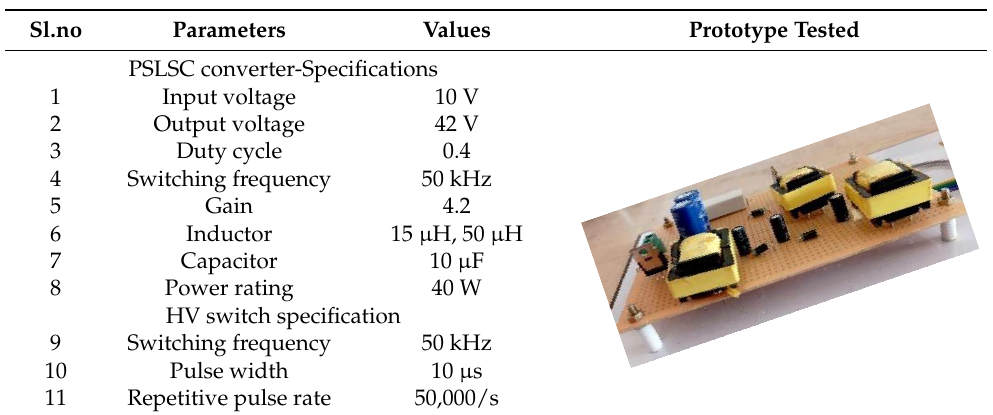
Table 8. Hardware Specifications of PSLSC converter.